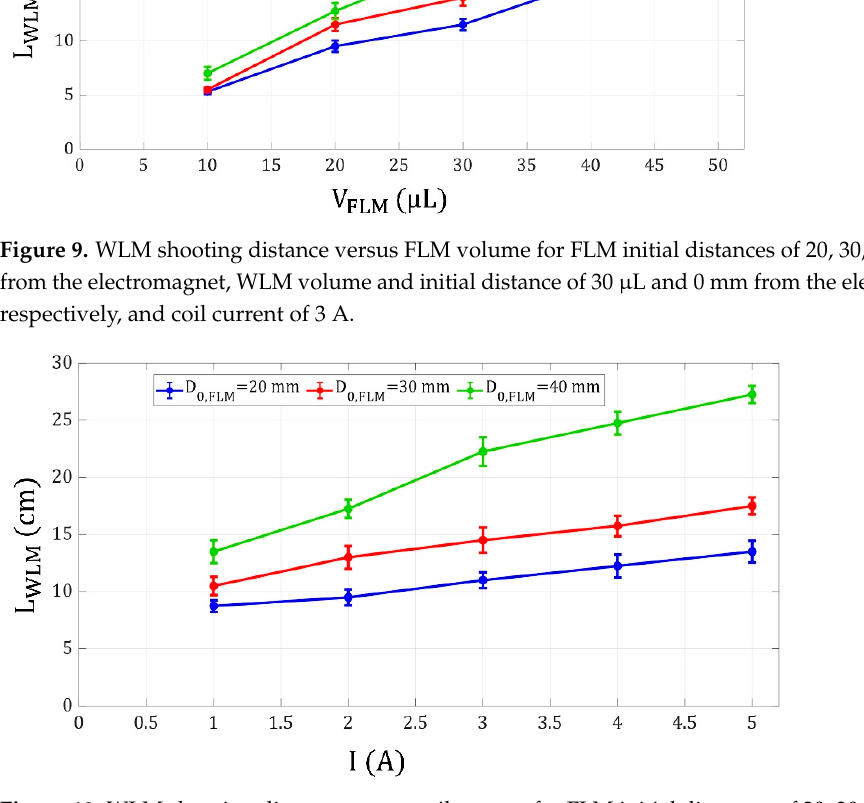
Figure 10. WLM shooting distance versus coil current for FLM initial distances of 20, 30, and 40 mm, WLM initial distance of 0 mm from the electromagnet, and liquid marble volumes of 30 μ L.